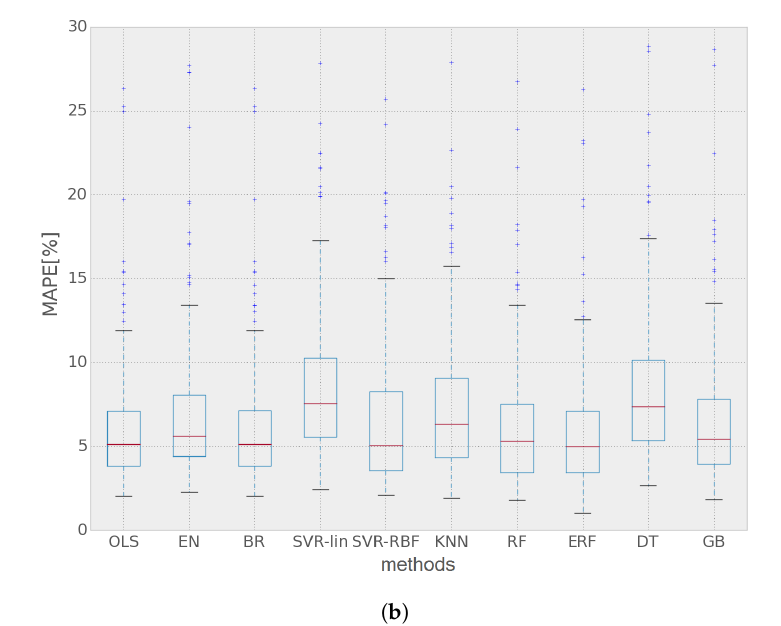
Figure 10. Boxplot showing the MAPE scores of the different methods for Network 1 ( a ) and Network 2 ( b ).